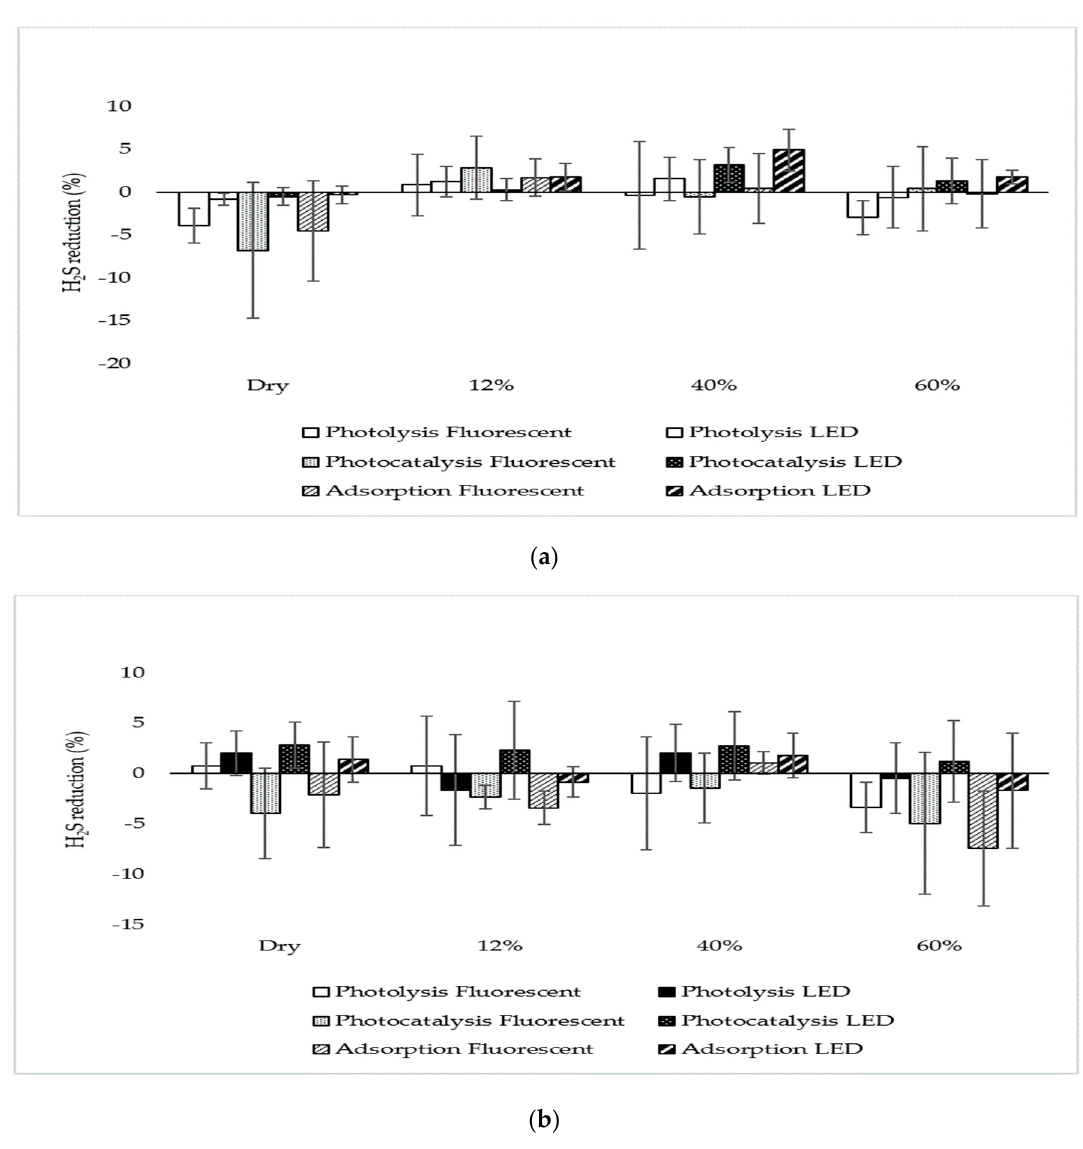
Figure 6. Comparison of H 2 S mitigation under relative humidity. ( a ) % reduction at a treatment time of 40 s; ( b ) % reduction at a treatment time of 200 s. Error bars signify ± standard deviation.